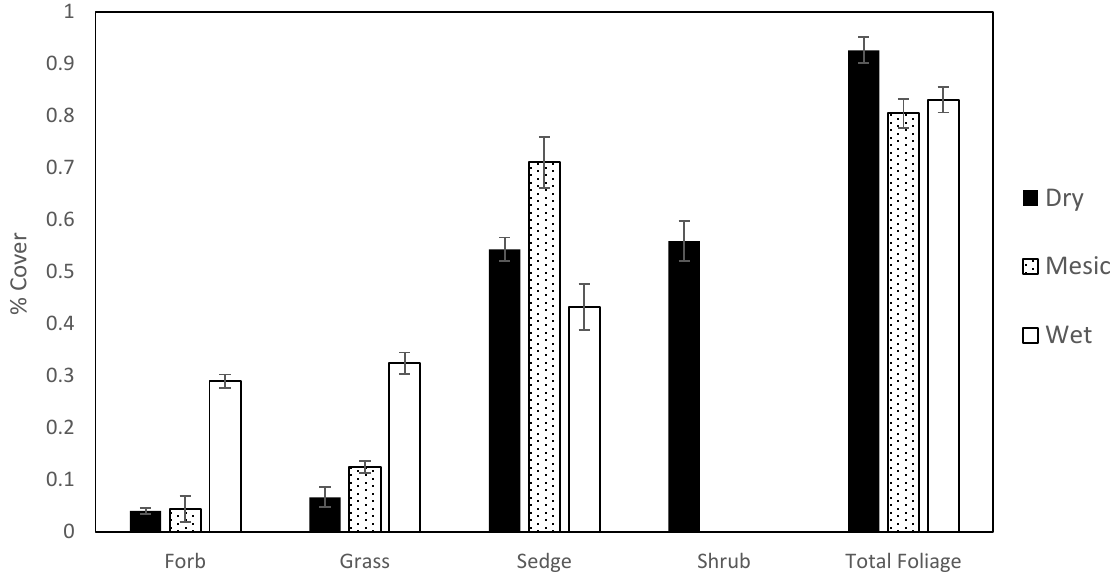
Figure 1. Line point intercept data grouped by percent foliar cover of functional type at four meadows in the Haypress Meadow complex in the Desatoya Mountains, Nevada,